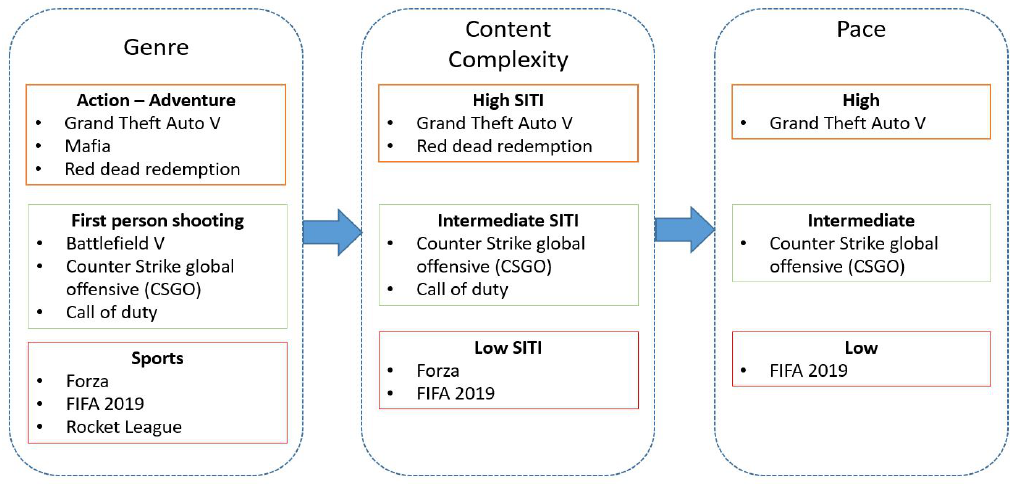
Figure 1. Stages of GuT